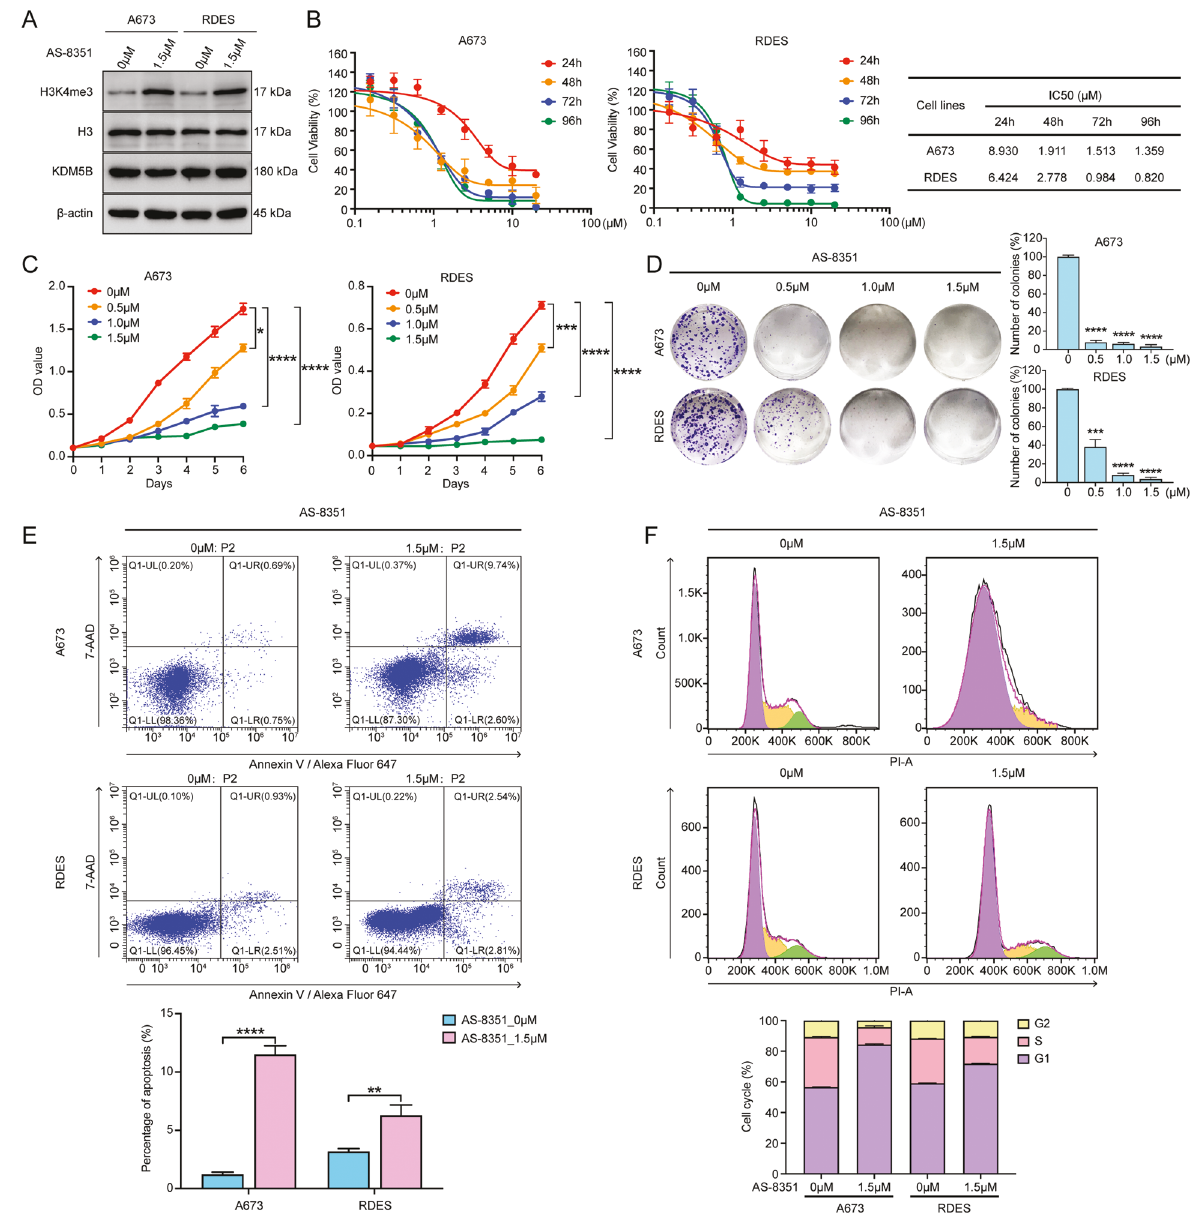
Fig. 3 KDM5B inhibitor AS-8351 suppresses the function of Ewing sarcoma cells. A Western blot analysis of KDM5B and H3K4me3 expression in A673 and RDES cells after AS-8351 treatment. B Cell viability assay of AS-8351 against A673 and RDES cell lines. Statistical chart showing the IC50 values of AS-8351 against A673 and RDES cell lines at different time points. C Growth curves of A673 and RDES cells after AS-8351 treatment. D Left panel: Representative images of colony formation assays of A673 and RDES cells after AS-8351 treatment. Right panel: Histogram of three biological independent experiments of colony formation assays. E Up panel: Representative images of cell apoptosis analysis of A673 and RDES cells after AS-8351 treatment using fl ow cytometry. Down panel: Histogram of three biological independent experiments of cell apoptosis analysis. F Up panel: Representative images of cell cycle analysis of A673 and RDES cells after AS-8351 treatment using fl ow cytometry. Down panel: Histogram of three biological independent experiments of cell cycle analysis. Error bars in B , C , D , E , F indicate standard deviation of three biological independent experiments. P values in C are determined by two ‐ way ANOVA test. P values in D , E are determined by two ‐ tailed unpaired Student ’ s t test. *Above the bars indicates signi fi cant difference; * P < 0.05, ** P < 0.01, *** P < 0.001, **** P < 0.0001. suppression causing by KDM5B depletion (Fig. 4F and G). Taken study. To determine whether KDM5B promoted cell prolifera- together, we believed that CCNE1 was a functional target of tion depending on CCNE1, we performed functional rescue KDM5B. Since KDM5B is responsible for regulating the histone assays by transiently overexpressing CCNE1 plasmid with FLAG modi fi cation, playing a role in inhibiting the transcription of tag (CCNE1-OE) and vector plasmid in KDM5B knockdown cells downstream genes, we further explored the mRNA expression (Fig. 4E) and observed the change of their proliferation ability. level of CCNE1 when knocking down KDM5B. The results The results revealed that, compared with the vector group, the showed that KDM5B depletion did not affect CCNE1 expression CCNE1-OE group could signi fi cantly reverse the proliferation